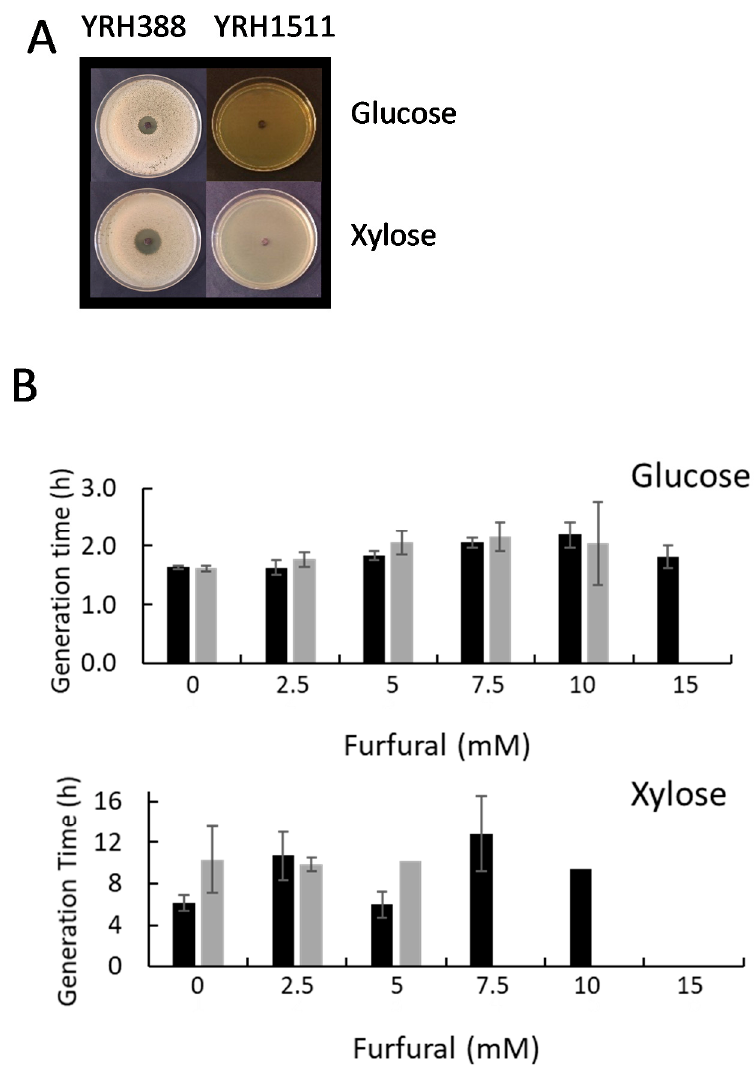
Figure 1. Inhibition by furfural. Comparison of inhibition of parental strain S. cerevisiae YRH388 and zwf1 -mutant YRH1511. ( A ). A filter disk saturated with liquid furfural (8 µ L) was placed in the center of a lawn of plated cells on YP medium containing 2% w / v glucose or xylose. Representatives of triplicate plates are shown. A small zone of inhibition was observed for YRH388, compared to nearly complete inhibition of YRH1511 after incubation for 96 h. Glucose plates were inoculated with 10 6 cfus; xylose plates were inoculated with 10 7 cfus. ( B ). Doubling times of YRH388 (black) and YRH1511 (gray) on YP medium containing glucose (top) or xylose (bottom) and furfural at varying concentrations. YRH1511, growing on glucose, did not grow when more than 10 mM furfural was present. In medium containing xylose, YRH1511 did not grow when greater than 5 mM furfural was present. Error bars show standard deviation of four replicates.